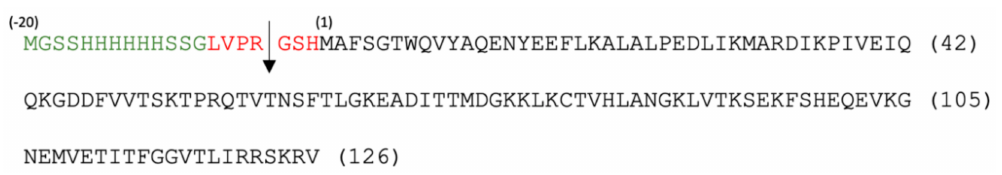
Figure 2. The sequence of His 6 -tag cL-BABP. Amino acids belonging to the His 6 -tag and to the thrombin recognition site are colored green and red, respectively, whereas the sequence of cL-BABP is indicated using black characters. The thrombin cleavage site is indicated by a black arrow. The sequence numbering refers to cL-BABP; thus, the translation start methionine is indicated by 1; negative numbers are used for the amino acids belonging to the removable His 6